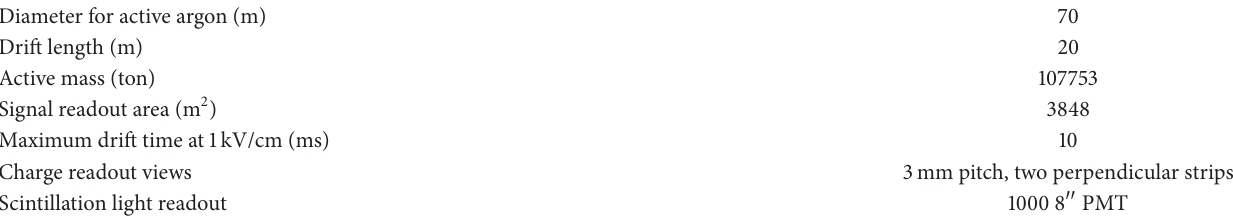
Table 5: Specification of giant liquid argon time projection chamber.